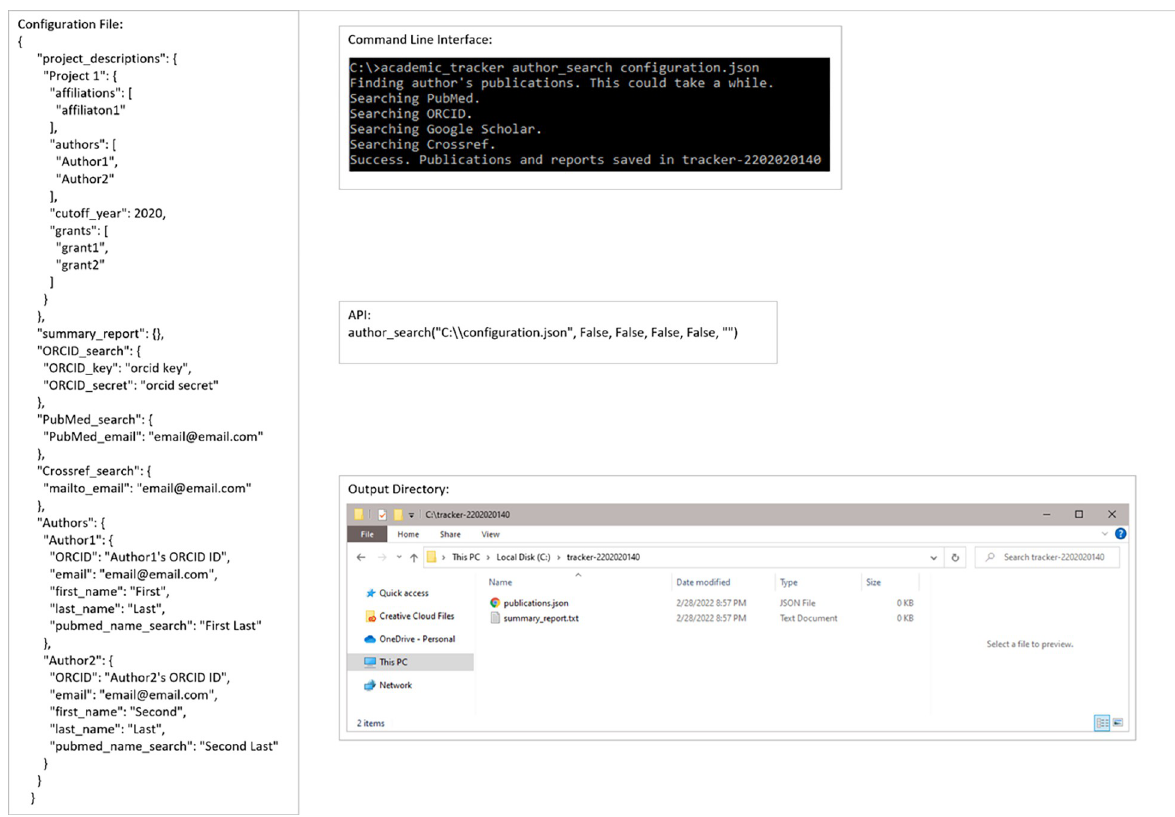
Fig 3. Example execution of the author_search use-case. Example configuration file, command-line execution, API execution, and file output of the author_search for publications use-case shown.